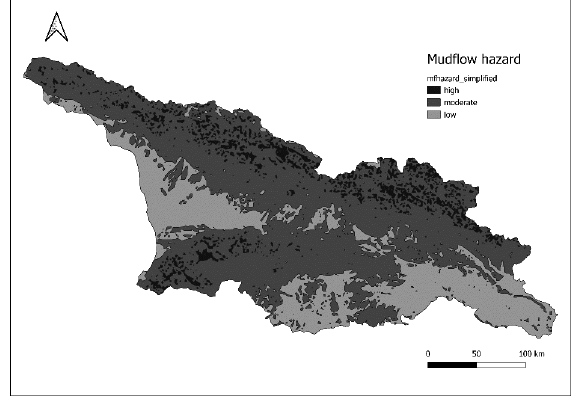
Figure 4. Mudflow hazard